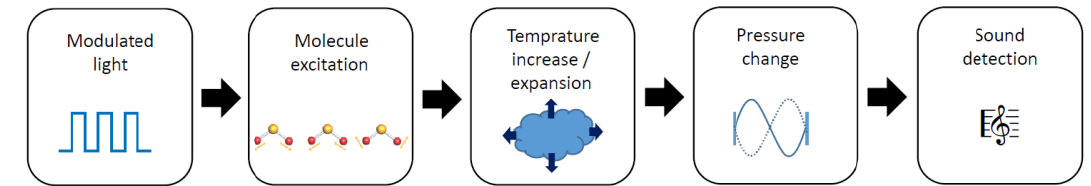
Figure 1. The photoacoustic detection principle of gases. Gas molecules absorb light at a specific wavelength, which excites the molecules to a higher energetic state. This results in a temperature increase and a consequent gas volume expansion, which is equivalent to a pressure change. A periodic modulation of the light source leads to a modulation frequency-dependent pressure change, which is equivalent to sound waves that can be detected by a microphone.